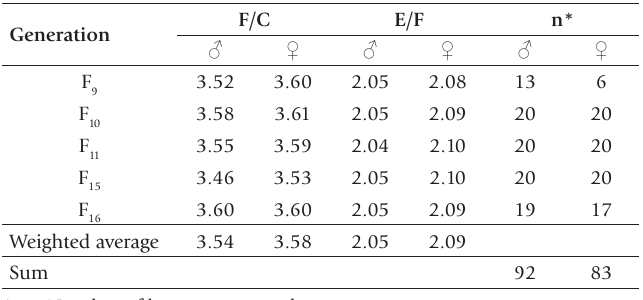
Table 3. Morphometrics of crowded Schistocerca gregaria , albino